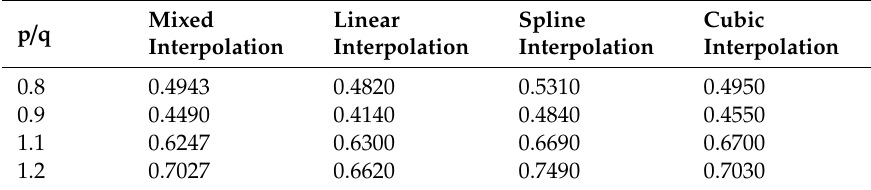
Table 2. Detection results of Wang et al. [16] under di ff erent interpolation methods. Mixed p / q